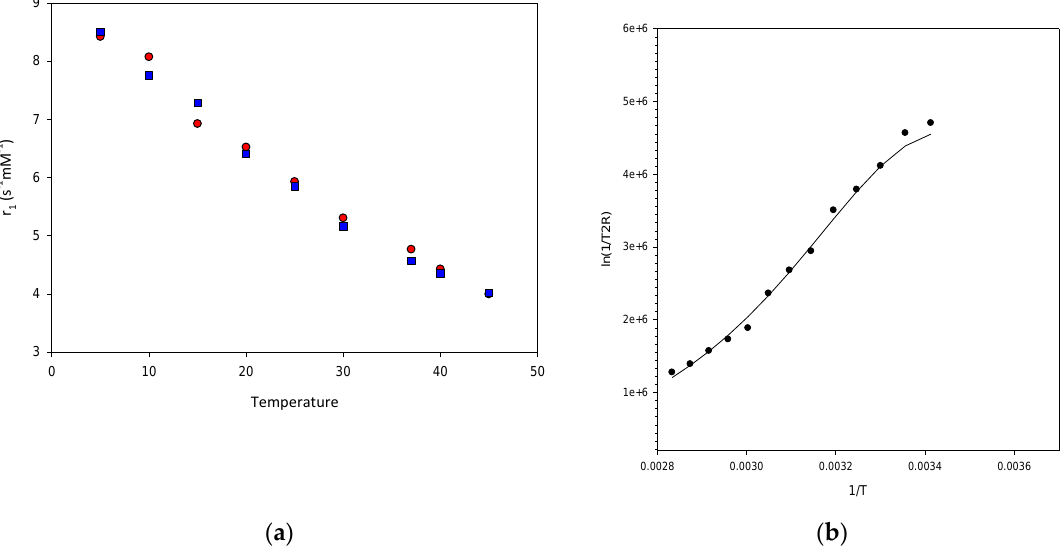
Figure 3 . ( a ) Measurement of the relaxivity of complexes 5 a (blue squares) and 7 a (red dots) at various temperatures in a magnetic field of 0.47 T. ( b ) Measurement of the 17 O water transverse relaxation rate at various temperatures in a magnetic field of 11.75 T.